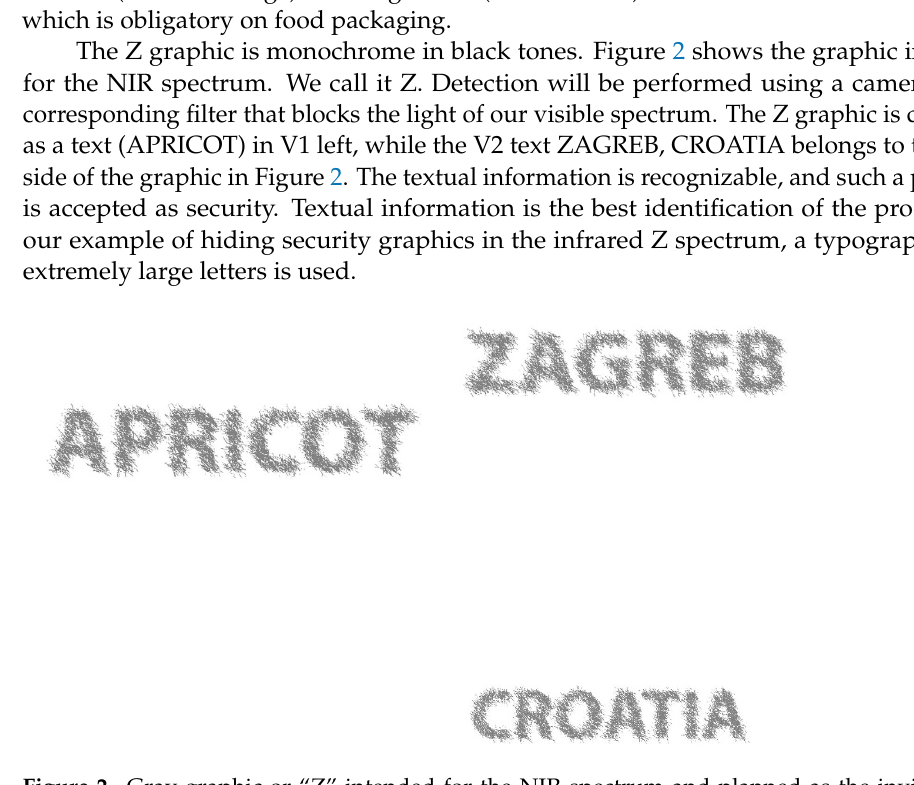
Figure 2. Gray graphic or “Z” intended for the NIR spectrum and planned as the invisible “Z” graphic.